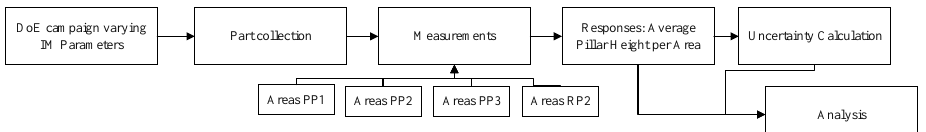
Figure 6. Flow diagram of the experimental sequence. The figure denotes the measurement areas on the part (i.e., PP1 = Part Position 1) and on the runner (i.e., RP2 = Runner Position 2) without the indication of cavity as seen in the text (i.e., Cavity 2 RP2 = C2RP2)